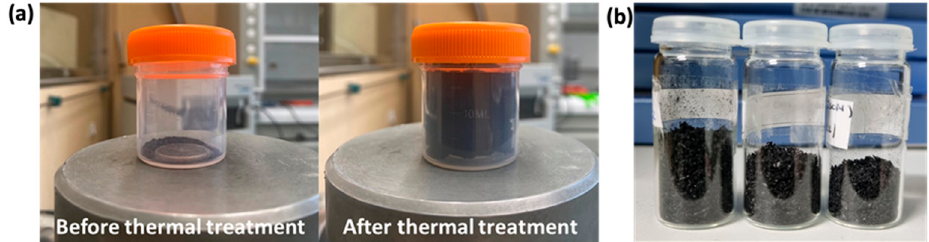
Figure 2. ( a ) Picture of the GO powder before reduction ( left ) and after reduction ( right ) using HP treatment. ( b ) Picture of LrGO material after reduction of GO powder using CO 2 laser irradiation. Each bottle, from left to right, contains the rGO obtained by applying a power of 1.6 W, 1.8 W and 2.0 W.